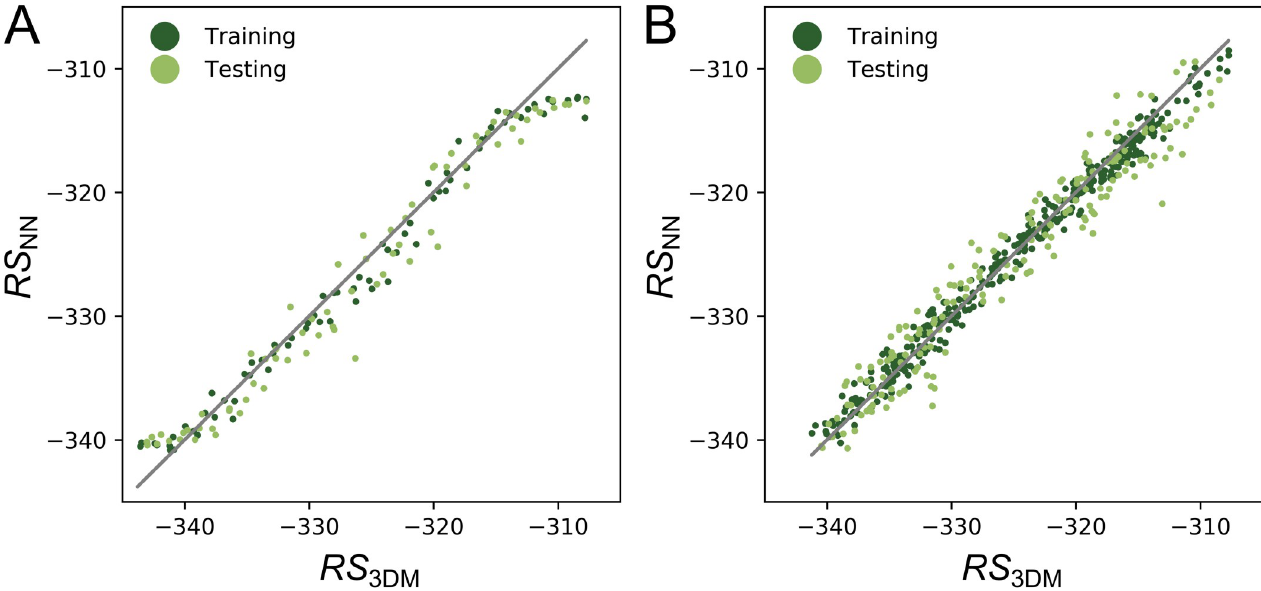
Fig 2. Performance of NNs for sequence sets with different sequence similarities. In both panels, Rosetta scores RS j deduced from 3D opt models are 3 DM plotted versus the Rosetta scores RS j predicted by NNs for an enzyme design. Scores are given in REUs and training and test data are represented as dark and NN light green dots, respectively. The gray lines indicate the diagonal, i.e. the position of perfect predictions. (A) Performance resulting for the dataset HisB_GA raw that consists mainly of sequences with point mutations. The PCC deduced from RS j and RS j values of the test data was 0.95. For reasons of clarity, a large 3 DM NN number of overlapping dots were removed; the plot shown in S2A Fig contains the full dataset. (B) Performance resulting from the redundancy-free dataset HisB_GA nr that consists of 533 sequences with a maximal pairwise sequence identity of 70%. The PCC was